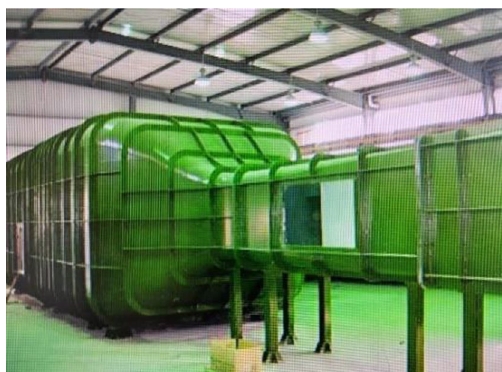
Figure 6. Low-speed backflow wind tunnel.